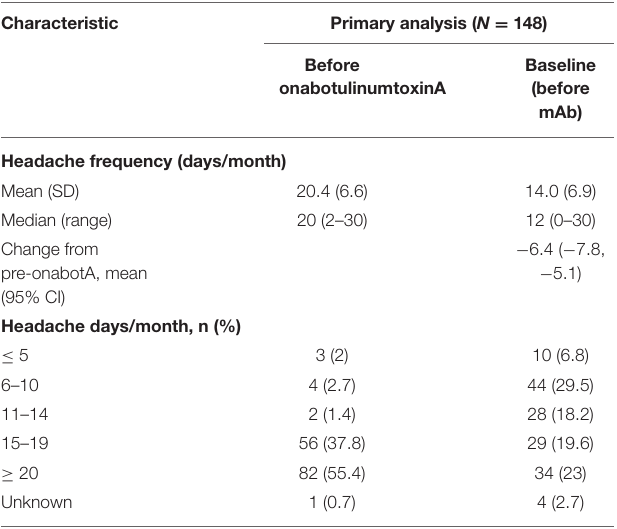
TABLE 3 | Headache characteristics and disability at